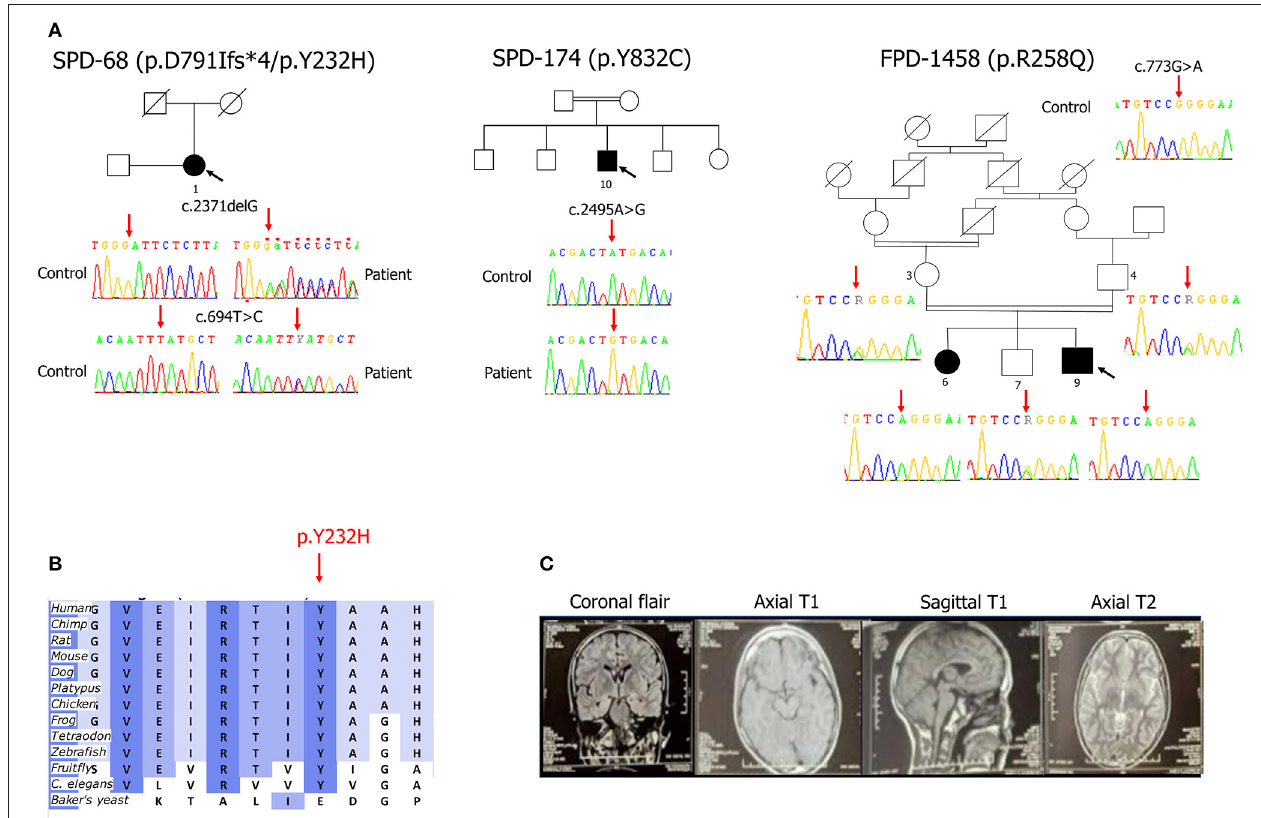
FIGURE 1 | (A) Pedigrees of the family and the two isolated cases with early-onset Parkinson’s disease carrying SYNJ1 mutations. Affected family members are represented by black circles (female) or squares (male). The arrow indicates the index cases. Double lines indicate consanguineous parents. The corresponding Sanger sequence electrophoregrams are shown. The p.R258Q mutation segregated with the phenotype in the FPD-1458 family: the p.R258Q genotypes are highlighted by a red arrow (heterozygous state for individuals 3, 4, and 7 and homozygous for the two affected siblings, 6 and 9). (B) Evolutionary conservation of the regions of the p.Y232 amino-acid sequences (download from Alamut ® Visual software, https://www.interactive-biosoftware.com/alamut-visual/). (C) Brain magnetic resonance imaging (MRI) for patient FPD-1458-9 showing the normal appearance of the various